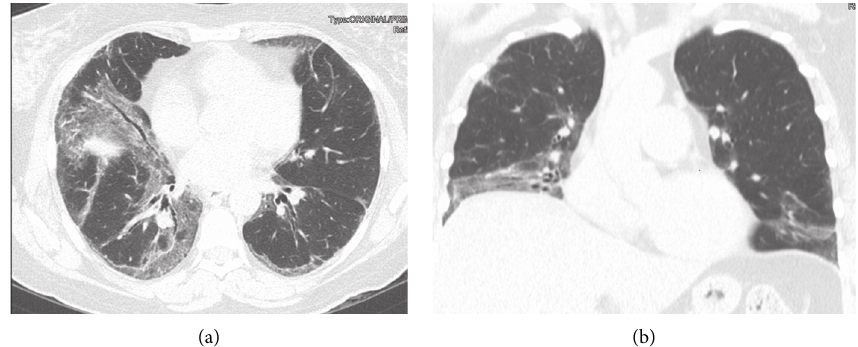
Figure 1: High-resolution computed tomography of the chest (Case 1). (a) Confluent ground glass opacity and consolidation, mainly in the mid and lower lungs, associated with moderate traction bronchiectasis. The distribution is partially subpleural with extension along the bronchial vascular bundles. Lung volumes are markedly reduced. (b) Coronal view demonstrating peri-diaphragmatic consolidation with an abrupt transition to normal parenchyma.